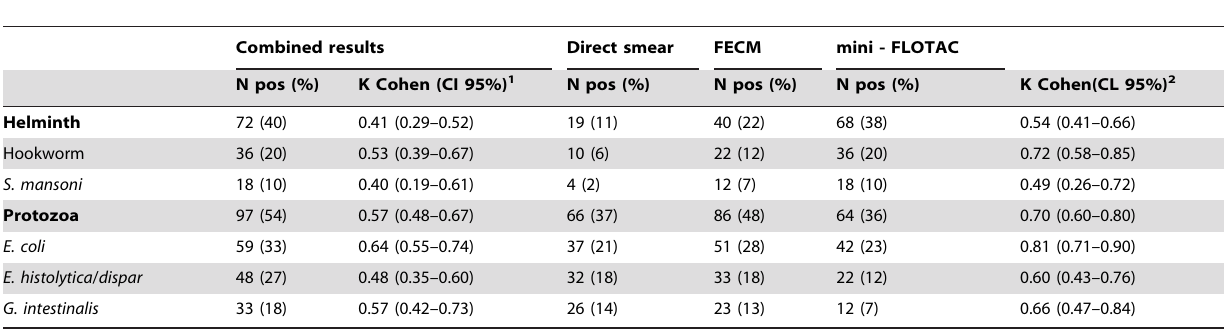
Table 2. Qualitative diagnosis of intestinal helminth and protozoan infections by direct smear, FECM and mini-FLOTAC method.